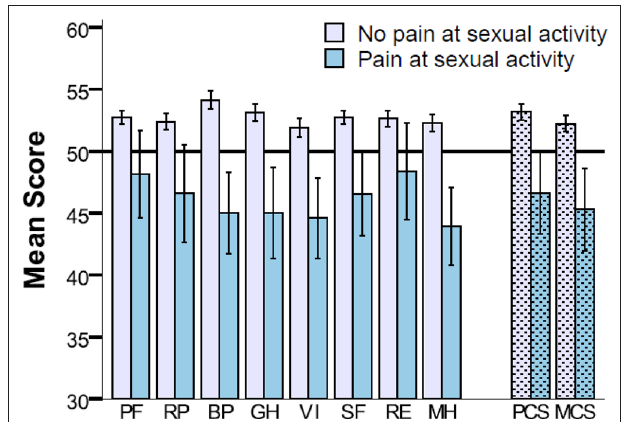
FigUre 4 | SF-36 shown with norm based scores for eight subscales and two composite scores for patients without ( n = 494) and with ( n = 44) pain during sexual activity (mean 50, SD 10). PF, Physical Function; RP, Role Physical; BP, Bodily Pain; GH, General Health; VI, Vitality; SF, Social Function; RE, Role Emotional; MH, Mental Health; and PCS, Physical Composite Score; MCS, Mental Composite Score. Error bars represents 95% confidence intervals.